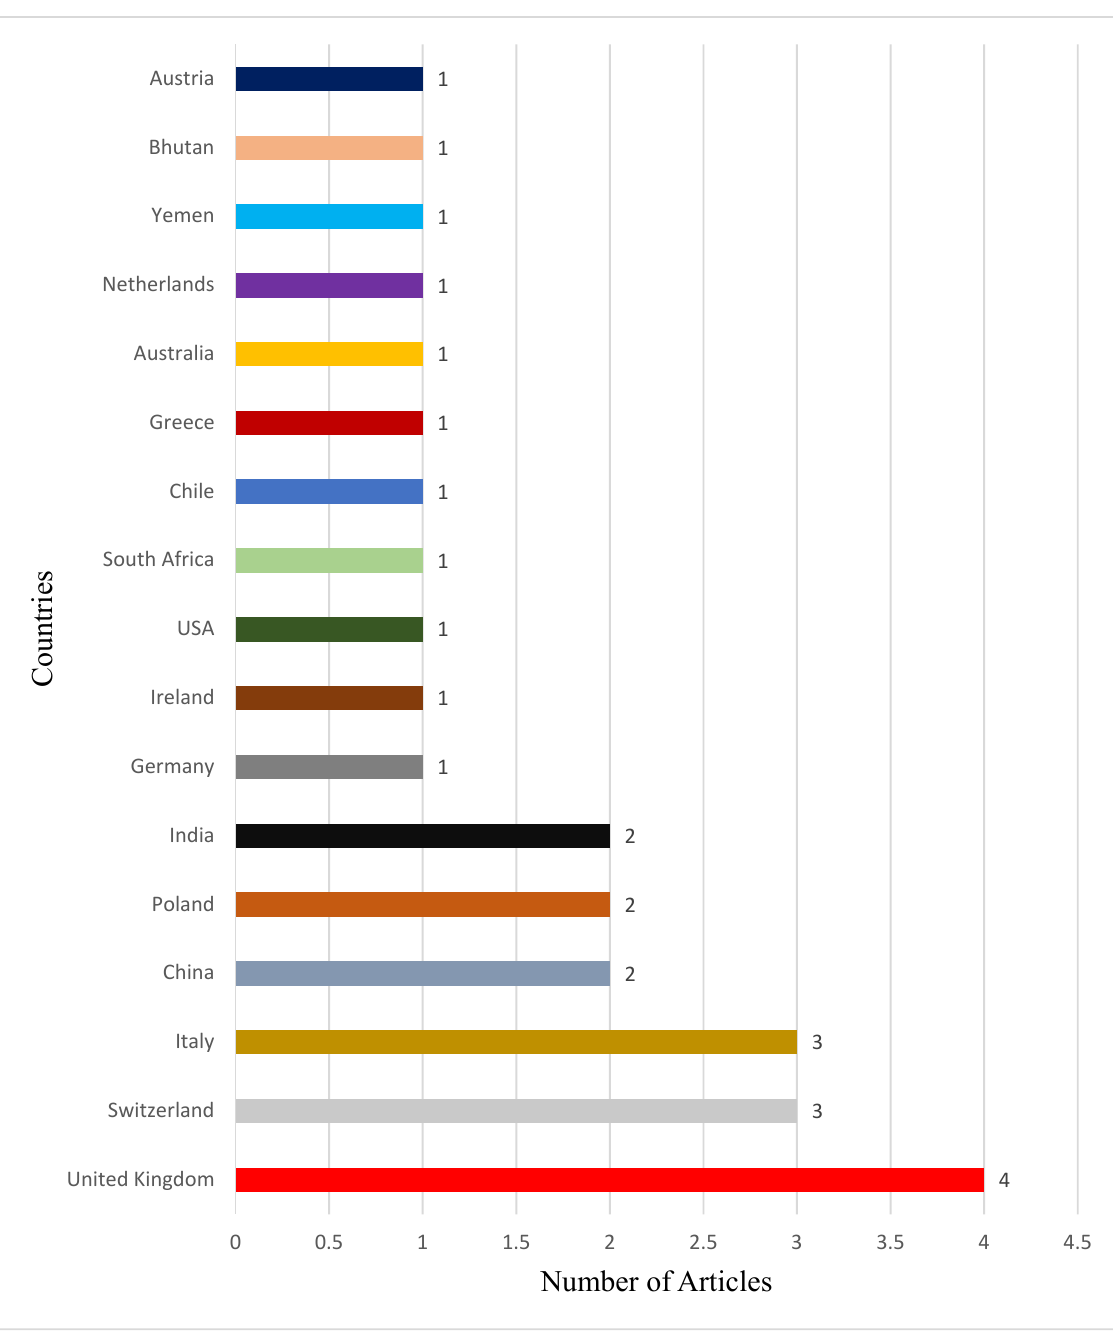
Figure 2. Distribution of countries based on their respective number of articles. Summary charac- teristics of studies included.